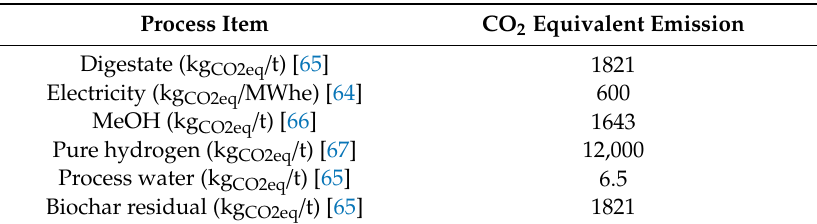
Table 3. CO 2 -equivalent emission